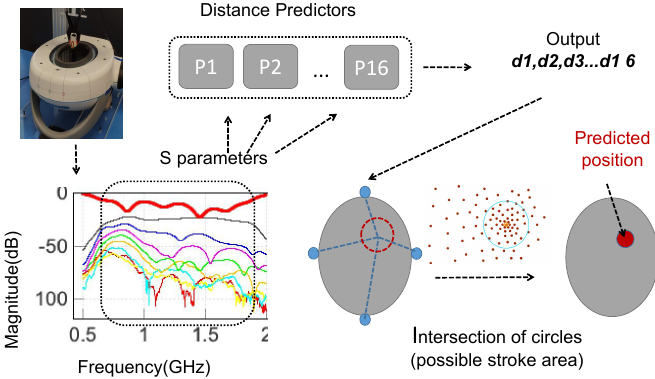
Figure 2. The two stages of proposed framework: prediction and localization.